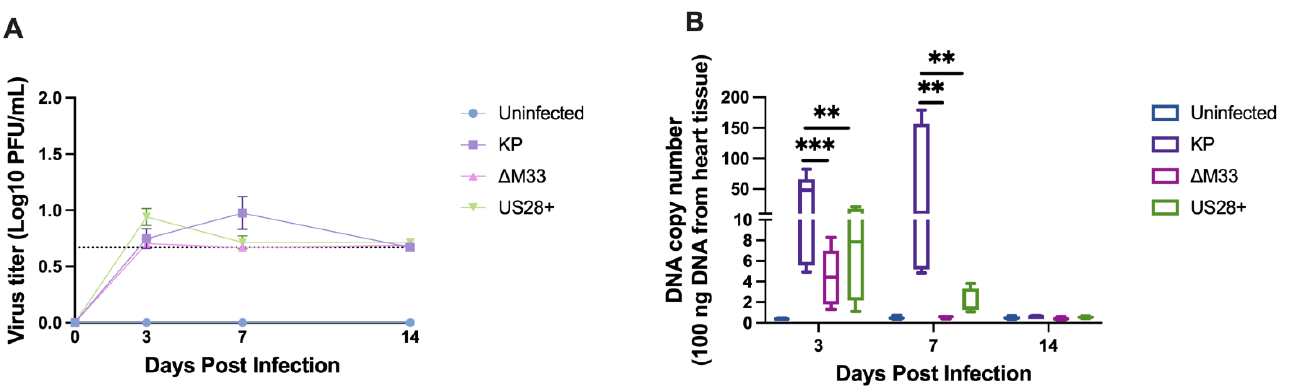
Figure 1. Wild-type and mutant MCMV acute infection within the heart. Animals were infected with 1 × 10 6 PFU by i.p. inoculation. At 3, 7, and 14 dpi, hearts were analyzed for ( A ) viral replication by plaque assay on 3T3 fibroblasts. Studies were conducted in duplicate ( n = 20) or ( B ) viral DNA load by qPCR using 100 ng DNA from heart tissue. DNA was quantified using a MCMV early gene 1 (E1) plasmid. Studies were conducted once ( n = 5). Group mean and standard error of the mean were calculated. Significance was determined by ANOVA and Tukey’s multiple comparisons test.